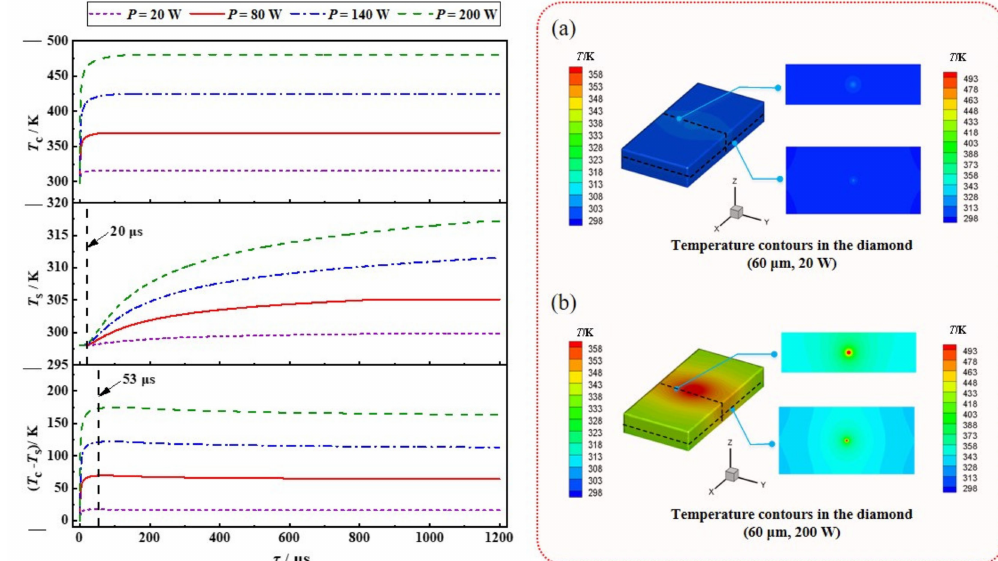
Figure 2. Temperature variation of diamond under different thermal powers in the heating process (top: center, middle: upper surface, and bottom: the difference). Inset: the temperature contours in the diamond with the heat source radius of 60 µ m and power of ( a ) 20 W, and ( b ) 200 W,